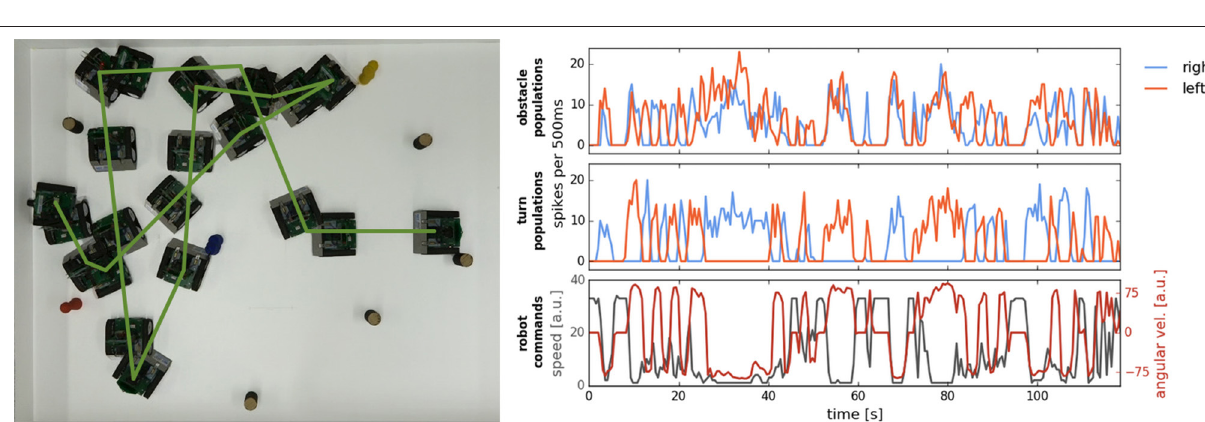
FIGURE 10 | Navigation in a cluttered arena. Left: Overlayed frames from the video, recoding the robotic arena from the top. Green line markes the path of the robot. Right: Summed activation of neurons in populations on the ROLLS chip over the time of the experiment. Obstacle and turn ( left and right ) population are shown, as well as the commands sent to the robot (angular velocity and